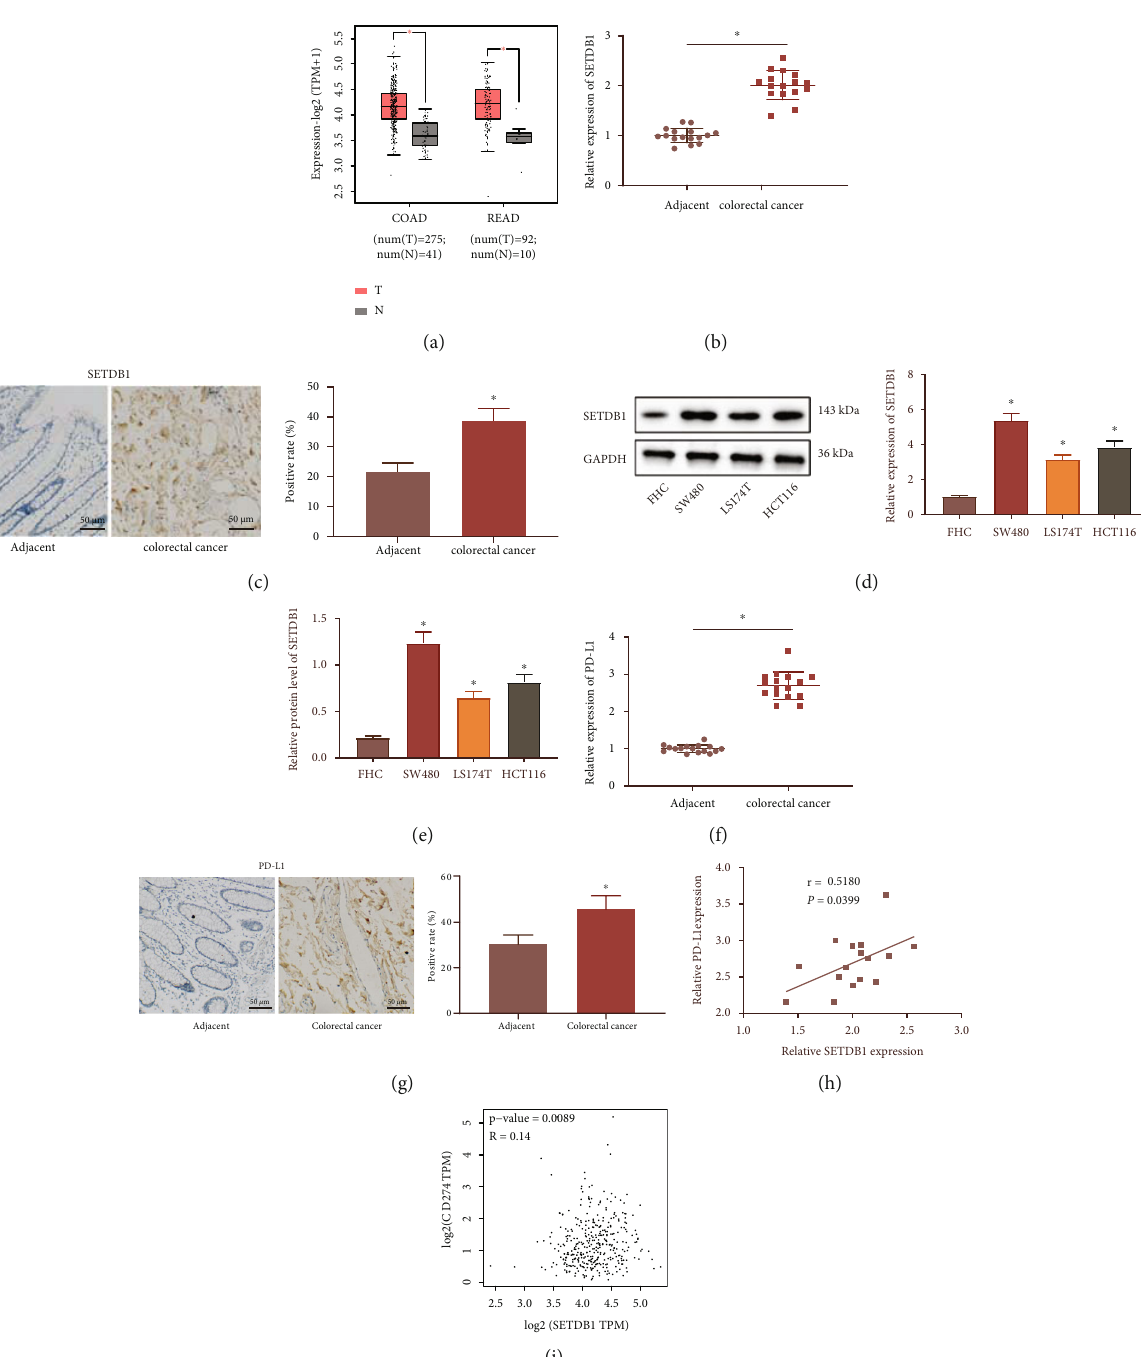
Figure 1: Upregulation of SETDB1 in CRC is positively associated with PD-L1 expression. (a) The expression of SETDB1 in adjacent normal and CRC tissues in TCGA database analyzed by GEPIA. (b) mRNA expression of SETDB1 in CRC tissues and adjacent normal tissues determined by RT-qPCR ( n = 36 ). (c) Protein expression of SETDB1 in CRC tissues and adjacent normal tissues determined by IHC ( n = 36 ), scale bar: 50 μ m. (d) mRNA expression of SETDB1 in FHC and CRC cell lines determined by RT-qPCR. (e) Protein expression of SETDB1 in FHC and CRC cell lines determined by RT-qPCR. (f) mRNA expression of PD-L1 in CRC tissues and adjacent normal tissues determined by RT-qPCR ( n = 36 ). (g) Protein expression of PD-L1 in CRC tissues and adjacent normal tissues determined by IHC ( n = 36 ), scale bar: 50 μ m. (h) Correlation between PD-L1 expression and SETDB1 expression in CRC tissues analyzed by Pearson ’ s correlation coe ffi cient. (i) The correlation between the expression of SETDB1 and PD-L1 (CD274) in CRC based on TCGA database. In (b, c, f, g), ∗ p < 0 : 05 vs. adjacent normal tissues. In (d, e), ∗ p < 0 : 05 vs. FHC cell line. The cell experiment was run in triplicate